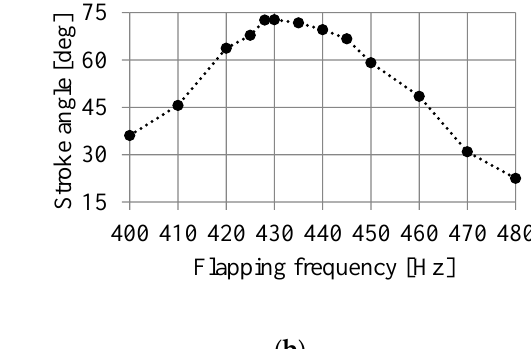
Figure 17. Frequency response functions of ( a ) the mean lift and ( b ) the stroke angle.